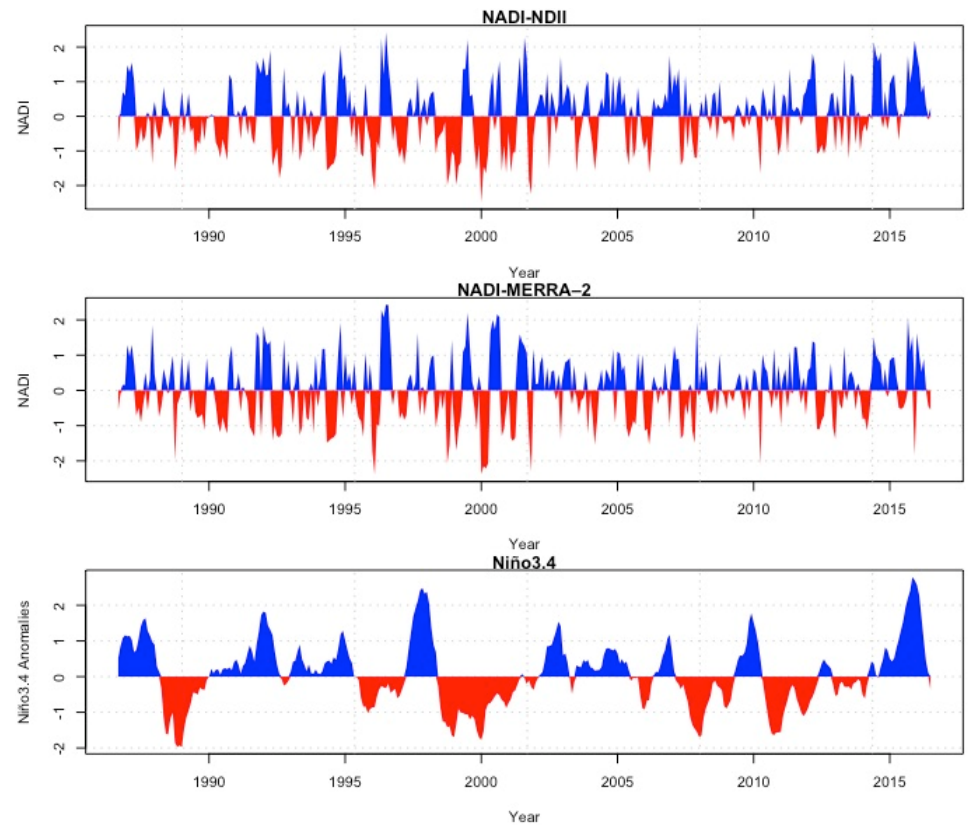
Figure 4. LRC NADI time series showing both the NDII and MERRA–2 soil moisture models including the Nino 3.4 climate index time series between 1986 and 2016.